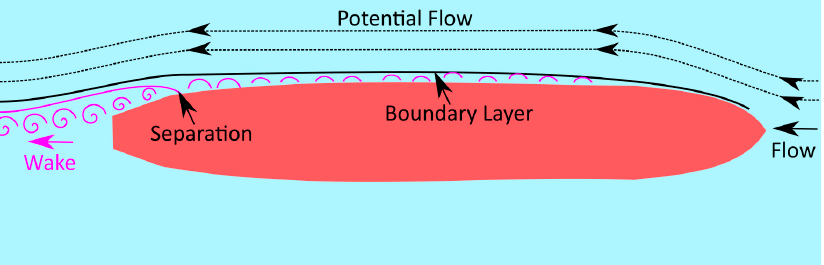
Figure 1. Boundary layer for a displacement ship.